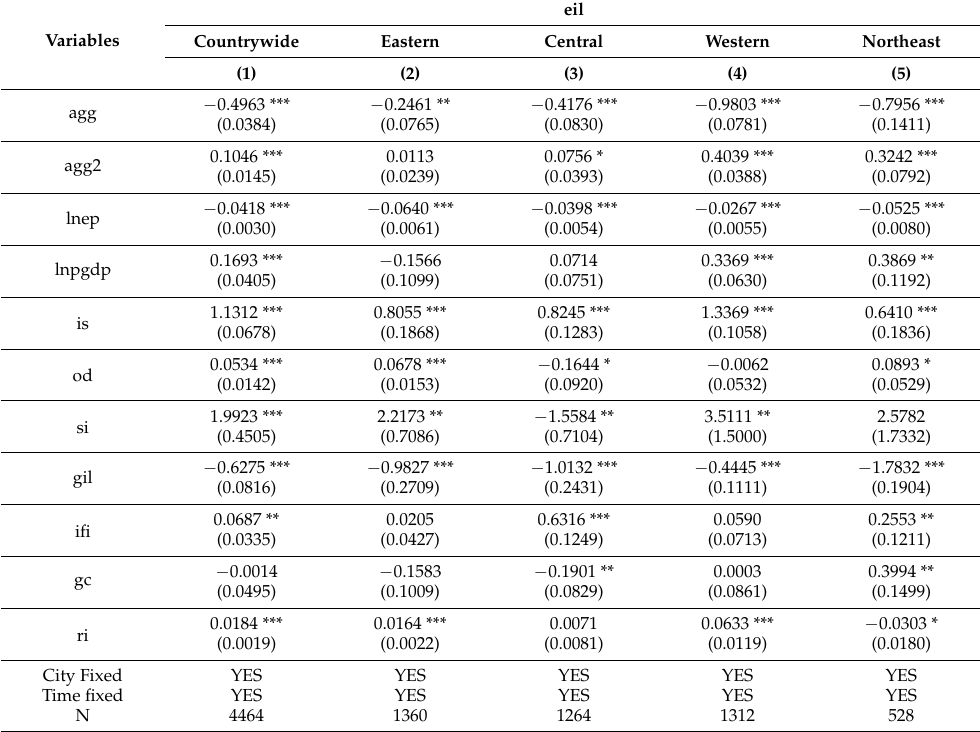
Table 5. Regression results of the effect of MA on GUEIL across China and different regions. Variables